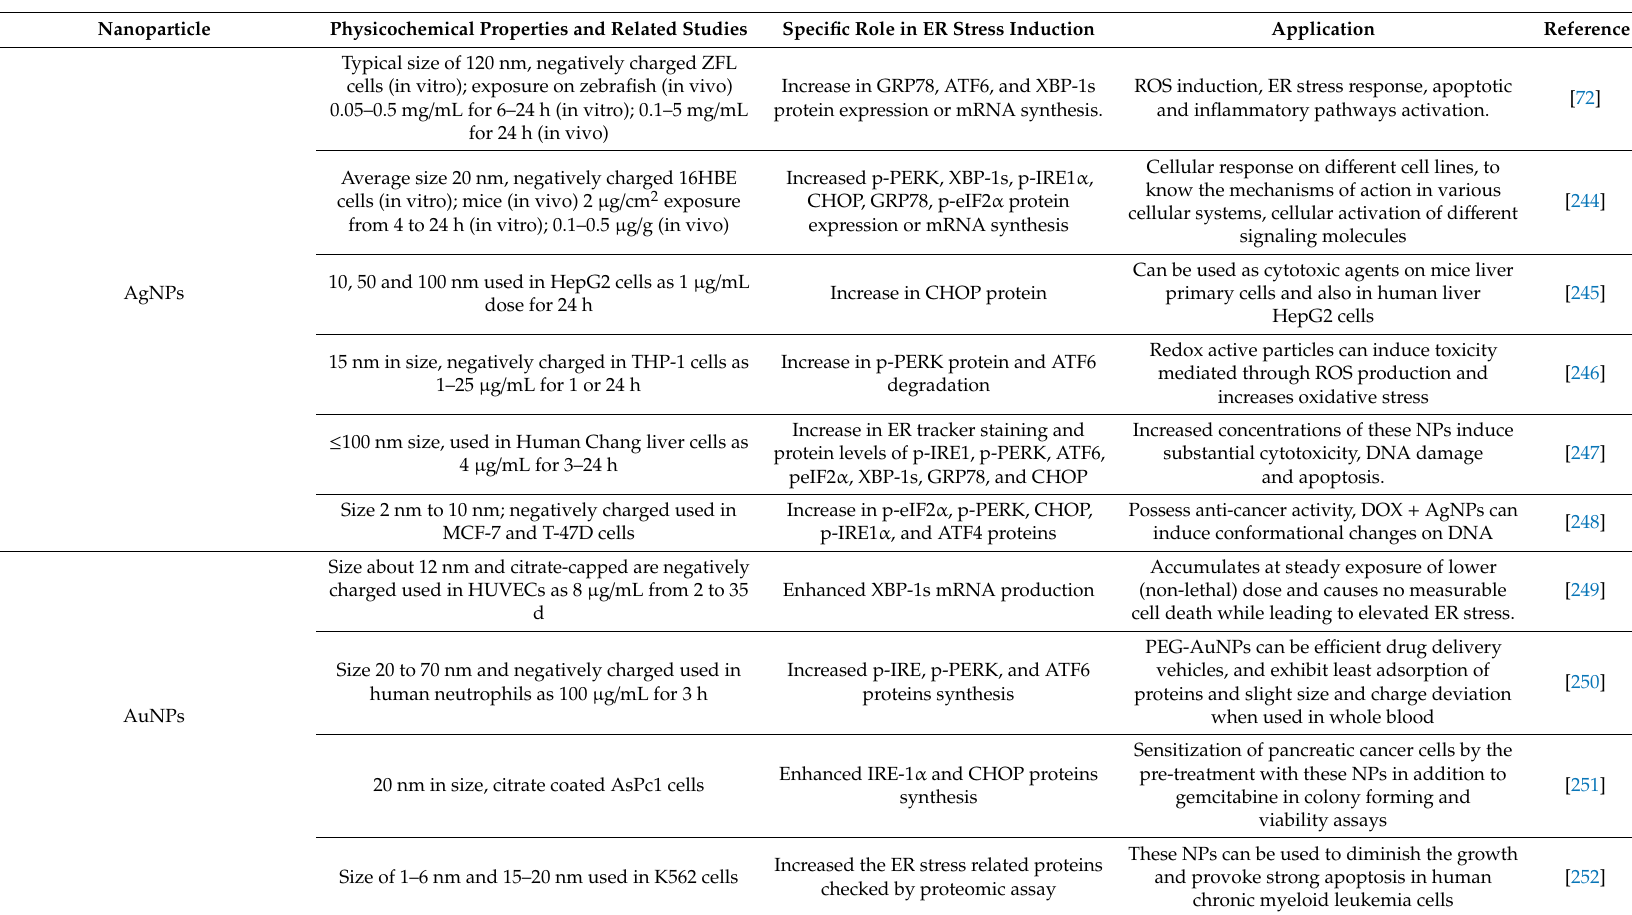
Table 3. Di ff erent types of metal and non-metal NPs possessing diverse physico-chemical properties that have specific roles in ER stress provocation and special applications, which were investigated to study their role in the management of cancer and other